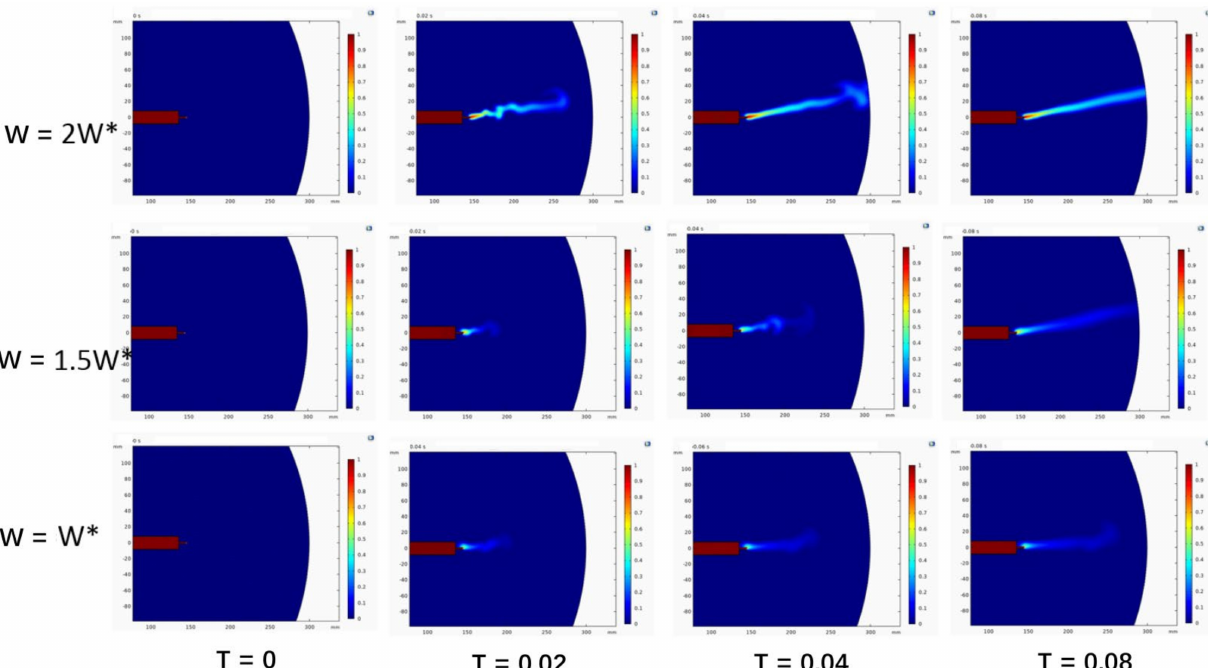
Figure 3. Turbulent transient integral cloud diagram of a jet at different speeds. (Note: In the figure, W* represents a dimensionless standard quantity, representing a certain rotational speed.)